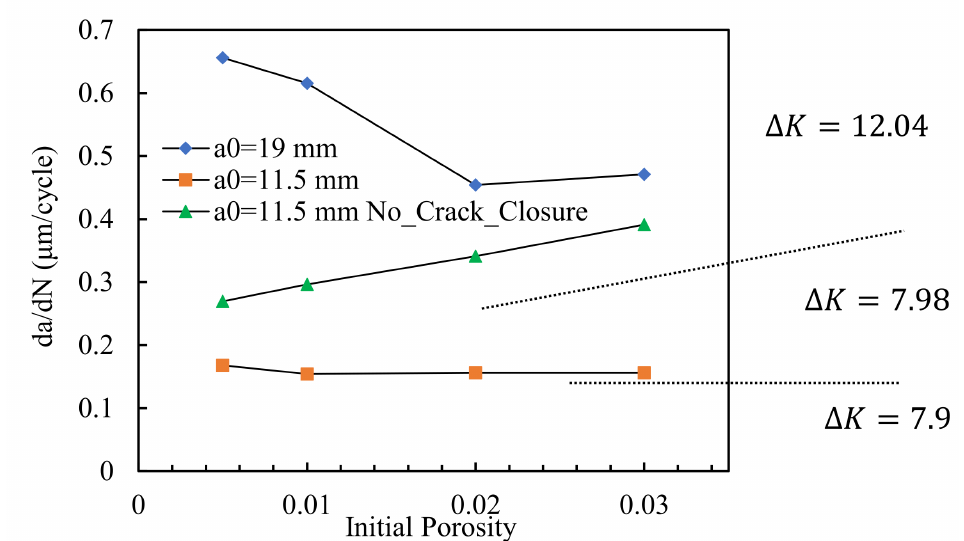
Figure 4. Fatigue crack growth rate in terms of the initial porosity for two distinct crack lengths ( a 0 = 11.5 mm and a 0 = 19 mm). Results are shown in natural scales. Nucleation and coalescence are